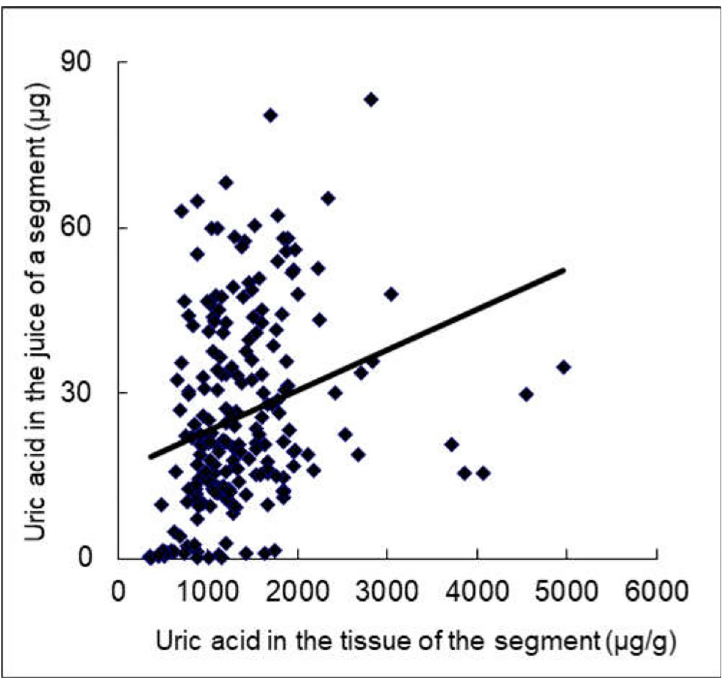
Fig 6. Correlation between Uric Acid (UA) in the Uox -/- rats’ intestinal tissue and their gastrointestinal juice who weighed 180–220 g (n = 210). R = 0.274, P = 0.000, Pearson correlation (two-tailed).